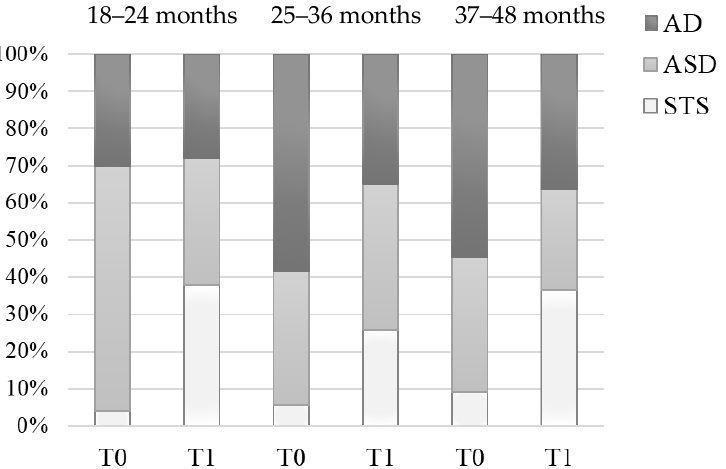
Figure 1. Participants’ distribution within the three severity groups as function of the age at baseline and follow-up visits.